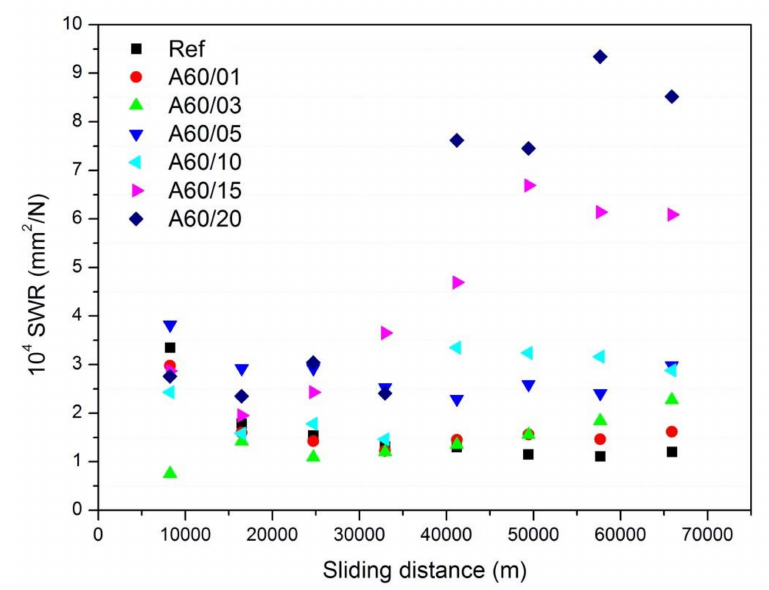
Figure 4. Evolution of SWR in the element pads containing different ELT rubber particles with the friction distance.